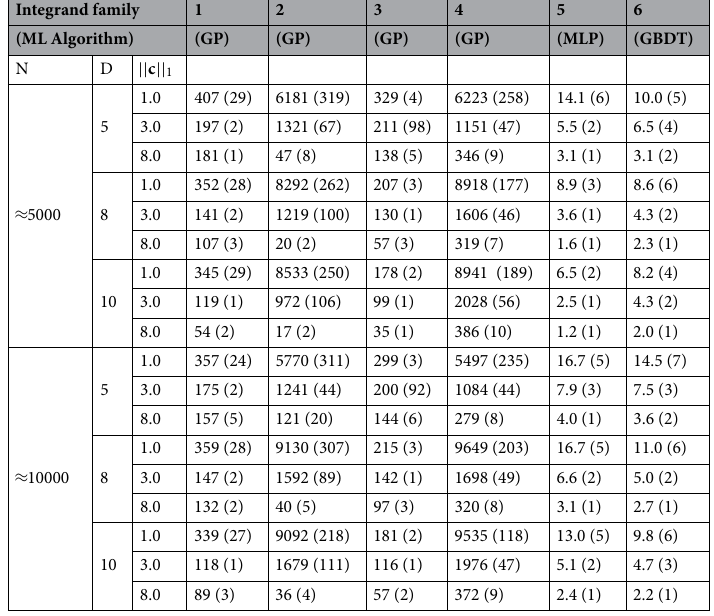
Table 1. Precision gain of the proposed algorithm over VEGAS, defined in Eq. (9), at two different number of integrand evaluations ( N ) for three dimensions ( D ) and three integrand difficulties ( || c || 1 ) on the six integrand families listed in Eq. (8). The results are averaged over 36 random samples. The numbers in the parentheses are the standard deviation of the